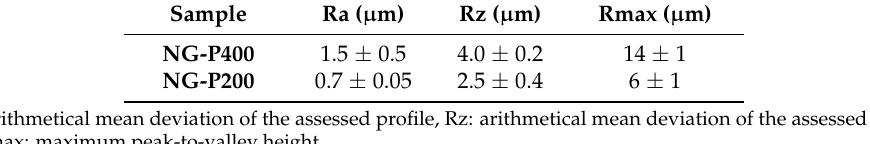
Figure 4. Microscope images of micropatterned mold.